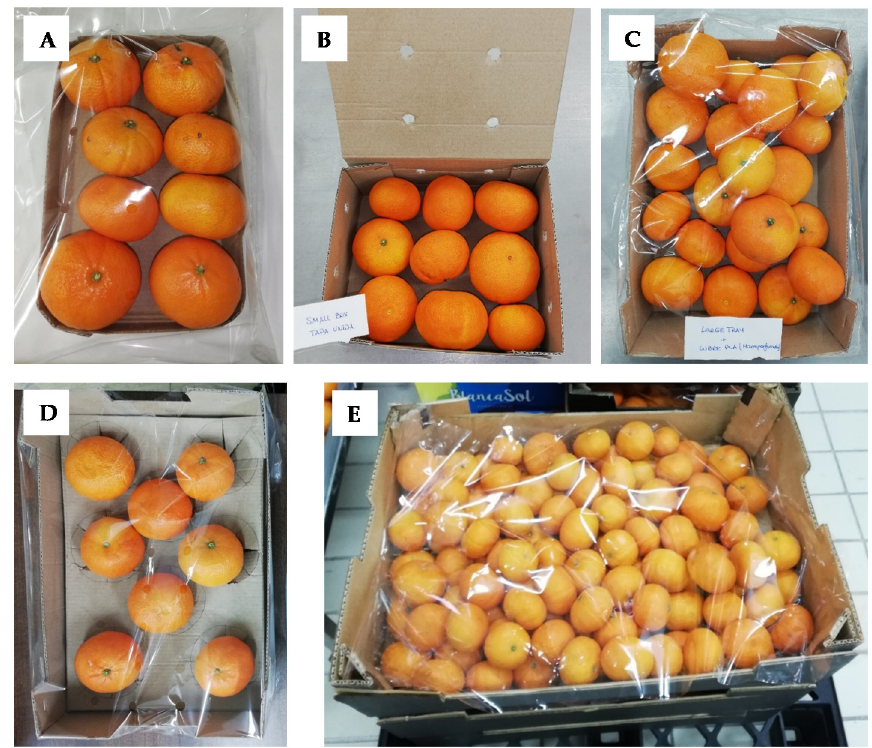
Figure 1. Package formats studied: ( A ) small tray (ST); ( B ) small box (SB); ( C ) large tray (LT); ( D ) large tray+alveoli (LT+); E, large box (LB).